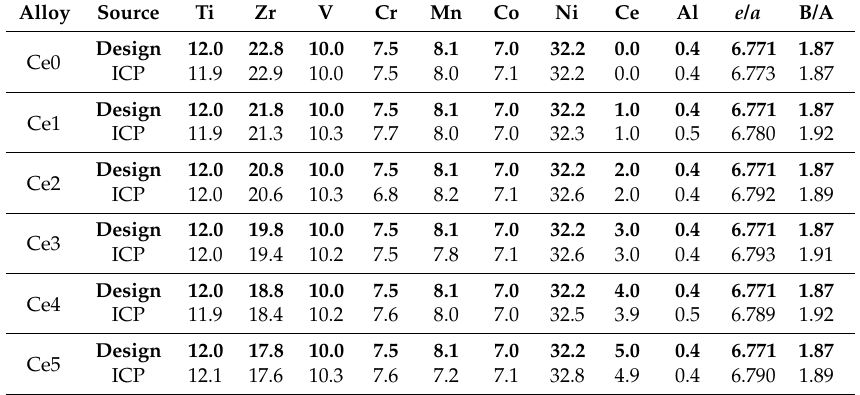
Table 2. Design compositions (in bold ) and inductively coupled plasma (ICP) results in at%. e / a is the average electron density, and B/A is the ratio of the B-atom-content (V, Cr, Mn, Co, Ni, and Al) to the A-atom-content (Ti, Zr, and